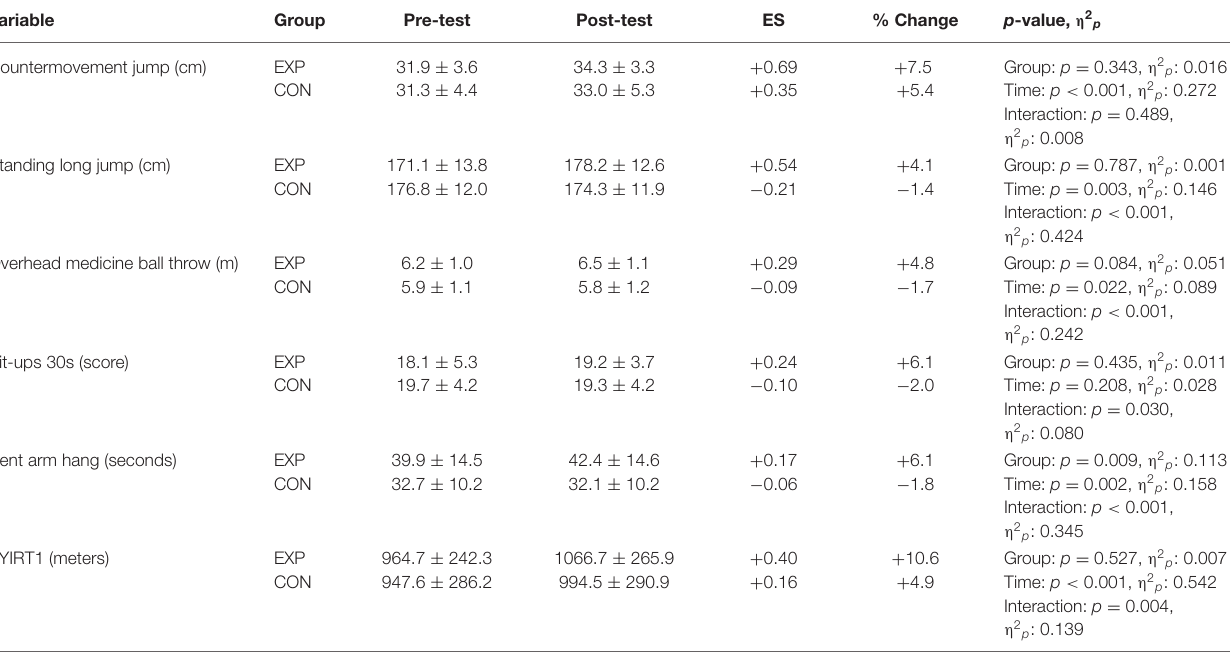
TABLE 2 | Physical fitness results and and changes from pre- to post-test in EXP and CON group. Variable Group